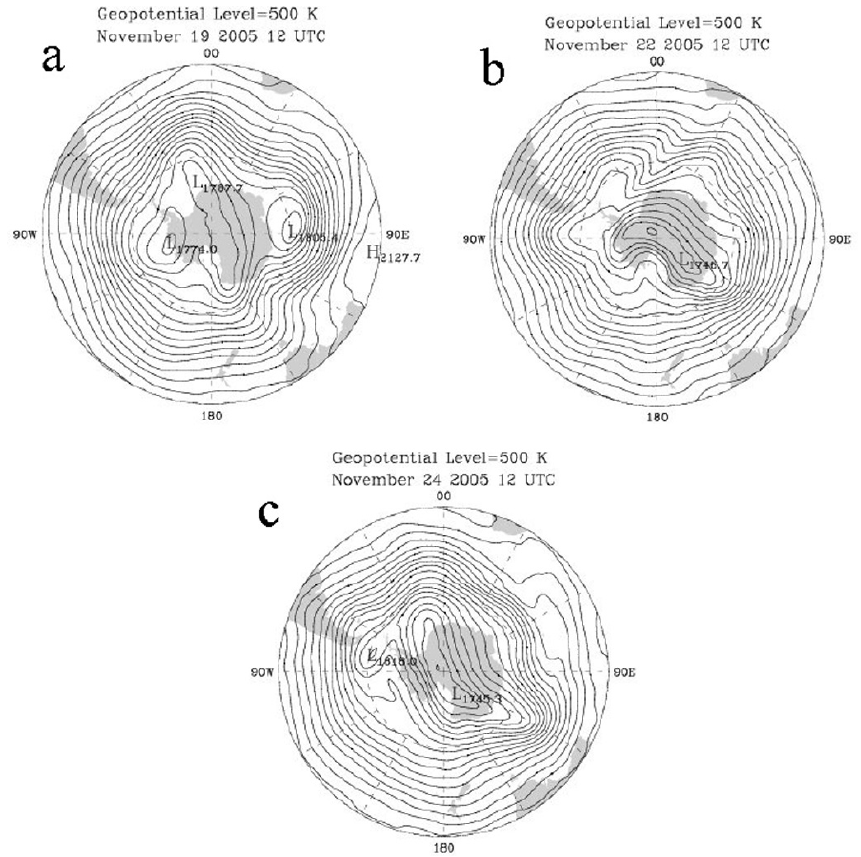
Fig. 3. Distributions of the geopotential field at 500K level from ECMWF: (a) on 12:00UTC, 19 November 2005, (b) on 12:00UTC, 22 November 2005, and (c) on 12:00UTC, 24 November 2005. The unit is